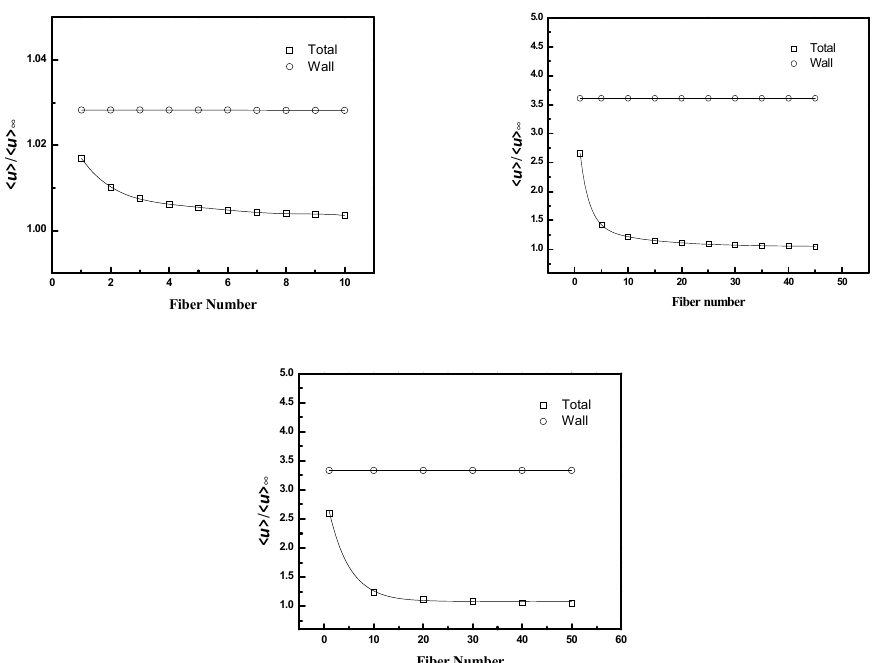
Figure 11. <u>/<u> ∞ as a function of fiber number for the whole flow channel (Total) and the channel adjacent to the wall (Wall): (top, left ) ɸ = 0 .4, D/R f = 2, (top, right ) ɸ = 0 .6, D/R f = 2, and (bottom) ɸ = 0 .4, D/R f = 3.